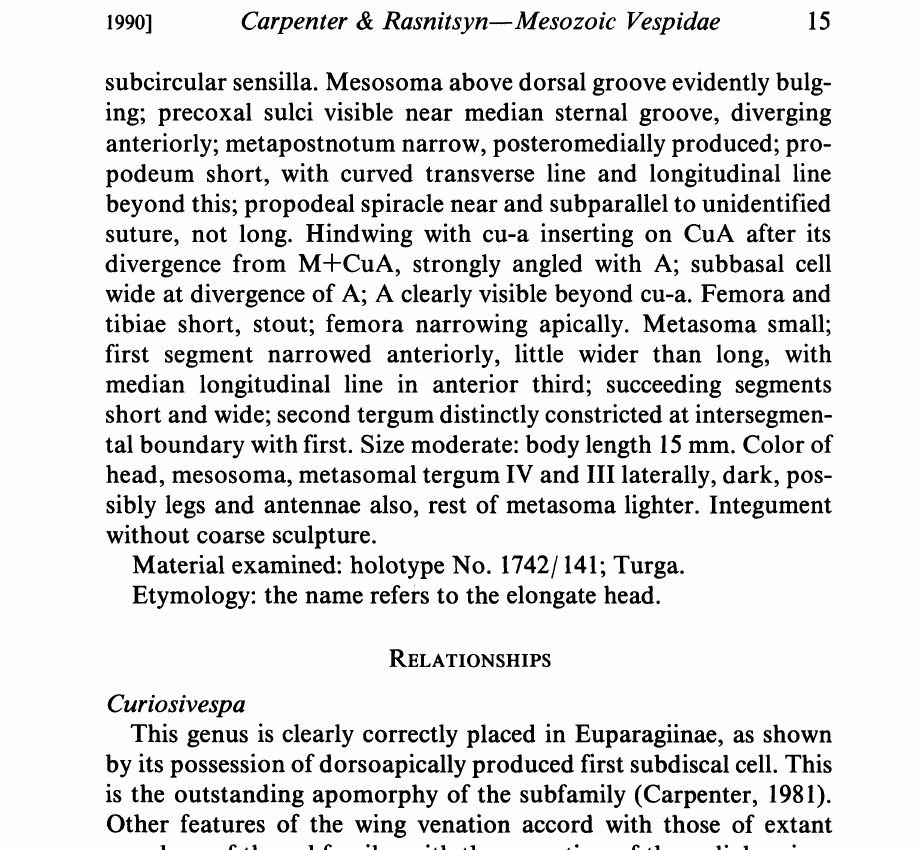
Fig. 11. Priorvespa bullata n.sp., holotype, fr-frons; lr-labrum; SII-second meta- somal sternum; Till-third metasomal tergum; other abbreviations as in Figs. 2, 6, 7, and 10. Fig. 12. Priorvespa longiceps n.sp., holotype, msg-median sternal groove; pN3-metapostnotum; ppsp-propodeal spiracle; other abbreviations as in Figs. 2, 6, 7, and